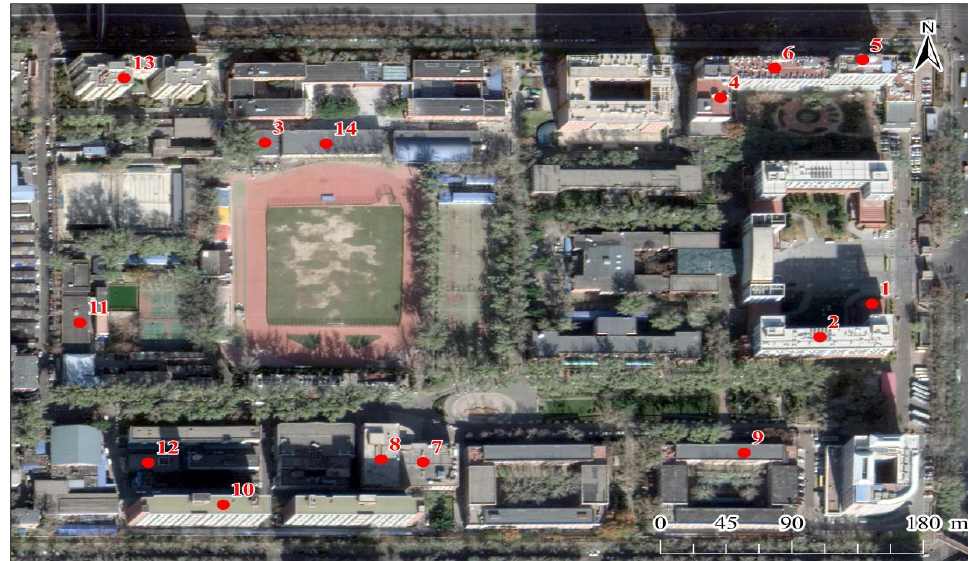
Figure 1. Distribution of the atmospheric dust fall sampling points in the study area.